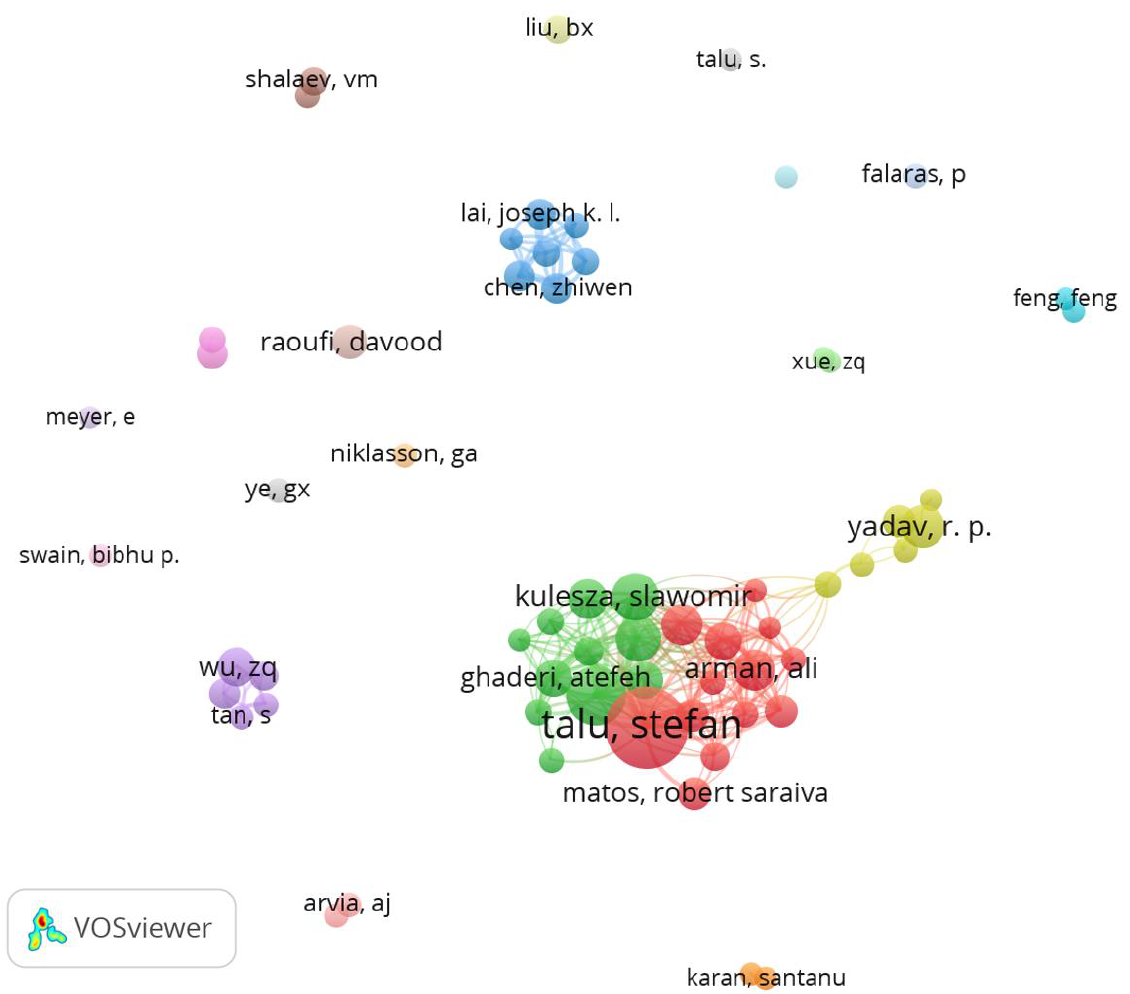
Figure 12. Co-authorship of authors researching fractal theory in thin film applications: minimum publication threshold of 5 documents and 20 citations per author.